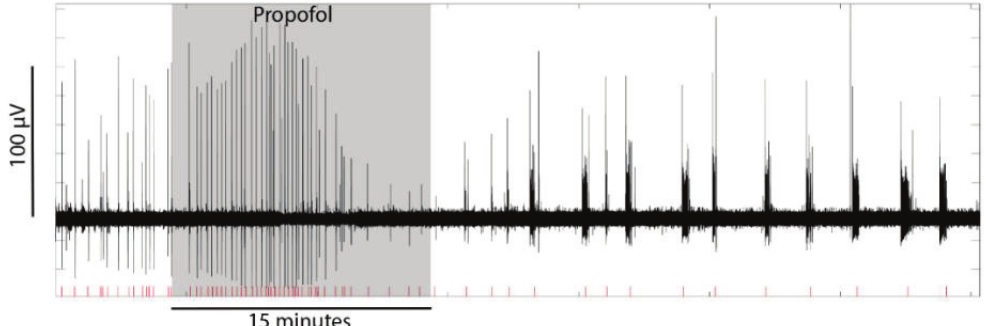
Figure 4. Example from one slice showing the effect of propofol on seizure-like event (SLE) activity. The shadowed region represents the period of drug delivery. The red lines in the figure illustrate how event frequency was quantified—in particular, that distinct bursts of activity were counted as single events.